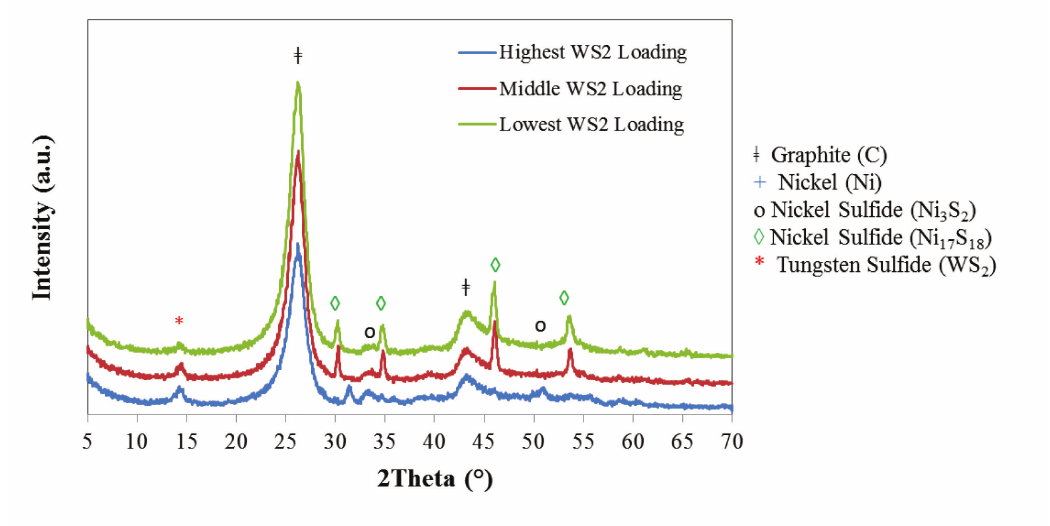
Figure 4. X-ray diffraction patterns for hybrid CNF/IF-WS between XRD patterns in samples at diverse loadings is the relative intensity for the nickel sulfide vs. graphitic